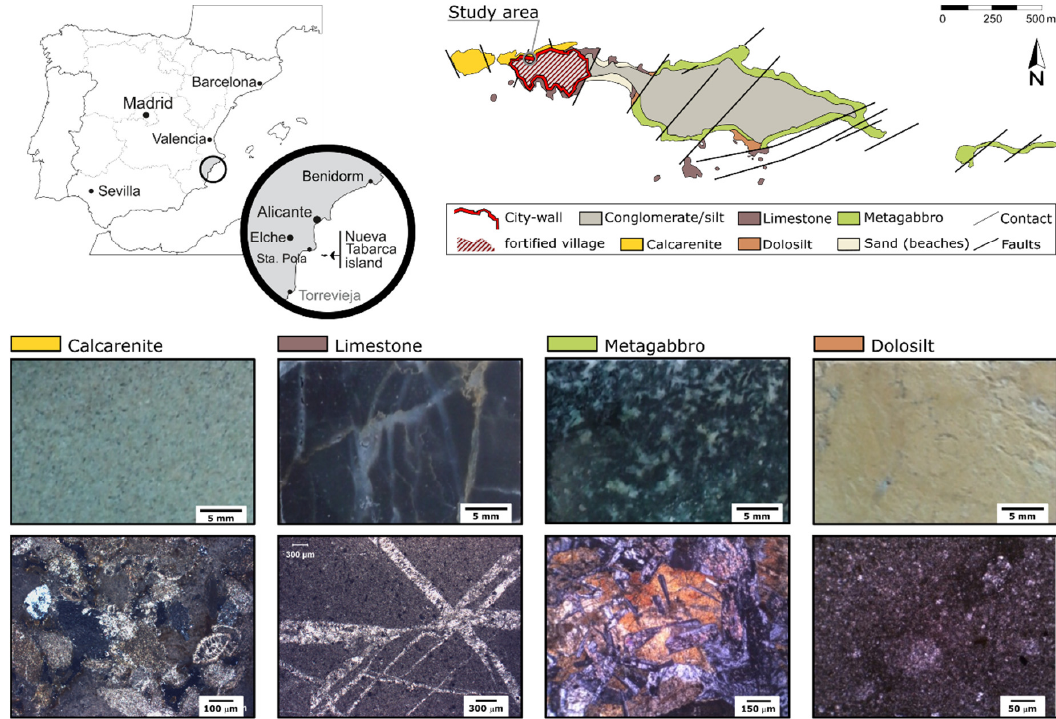
Figure 1. Location (top left) and geological map (top right) of Nueva Tabarca island. Photographs (first raw) and photomicrographs (second raw) of the main lithologies used as building rocks in the architectural heritage of the island.